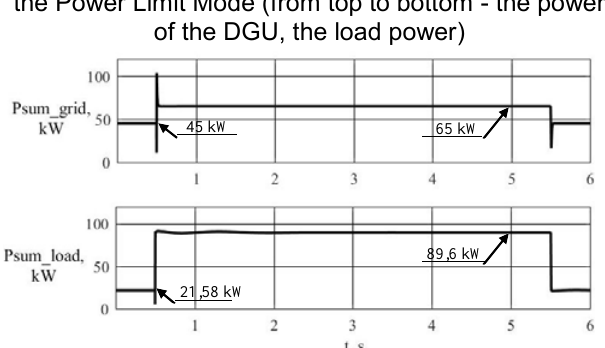
Figure 7. Calculation: transient process with ESS in the Power Limit Mode (from top to bottom - the power of the DGU, the load power)